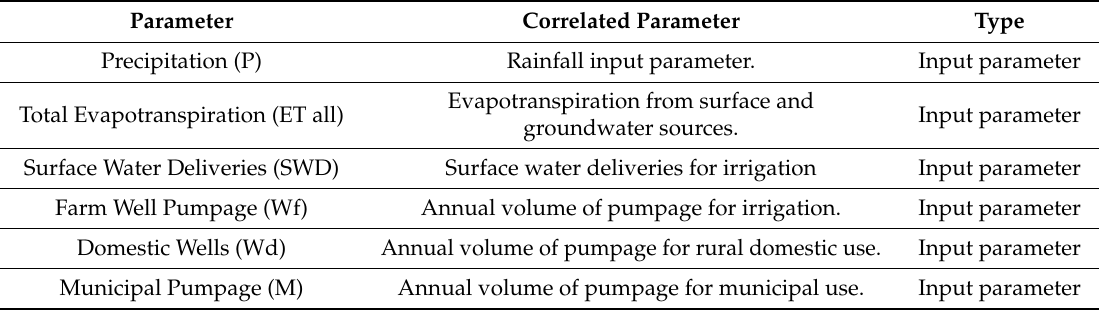
Table 4. Modesto Basin input parameters [17].